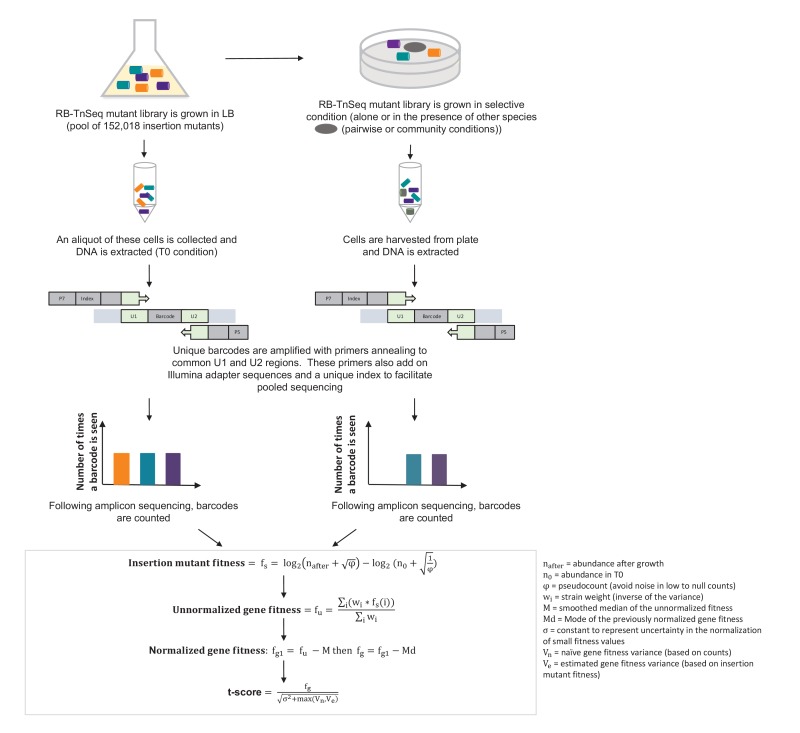
Pipeline of RB-TnSeq experiment using the E. coli Keio M9 library: from experimental set-up to normalized gene fitness and t-score calculation.Calculation of gene fitness from the Illumina sequencing files was performed using the Perl script BarSeqTest.pl from (Wetmore et al., 2015). The detailed description of the pipeline can be found in (Wetmore et al., 2015).